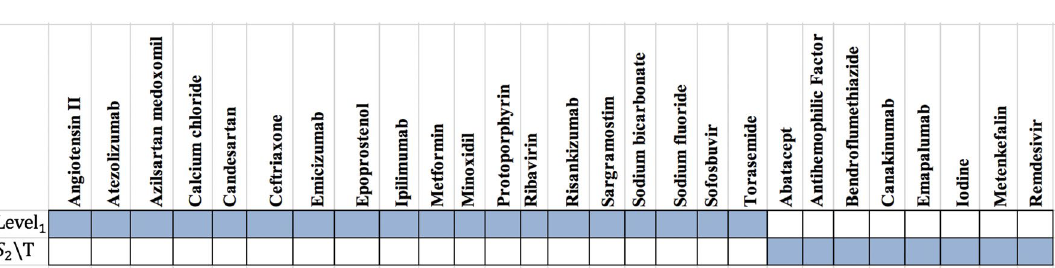
Figure 6. The presence (blue color) or absence (white color) of overlap of approved drugs in T and S 2 sets that are not approved with any of the proteins in T 2 set. The complete description of sets is presented in Table 1. Best results are indicated in bold